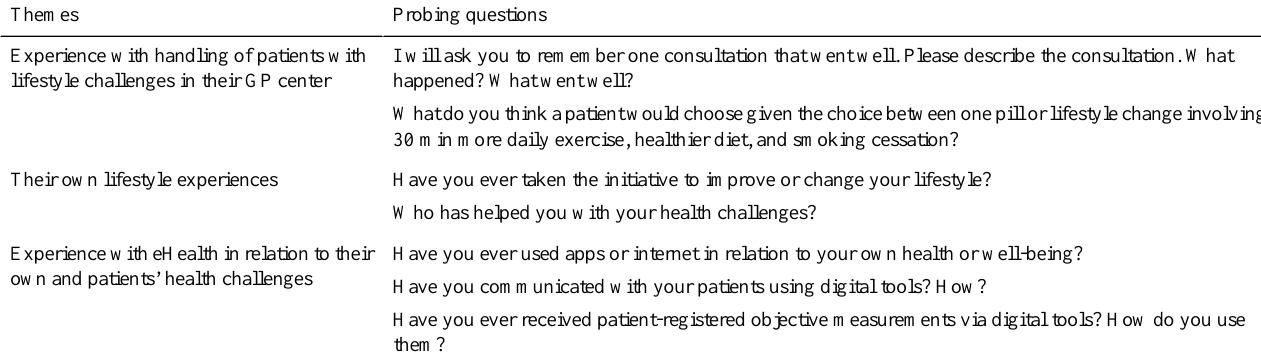
Table 1. Interview guide. GP: general practitioner.